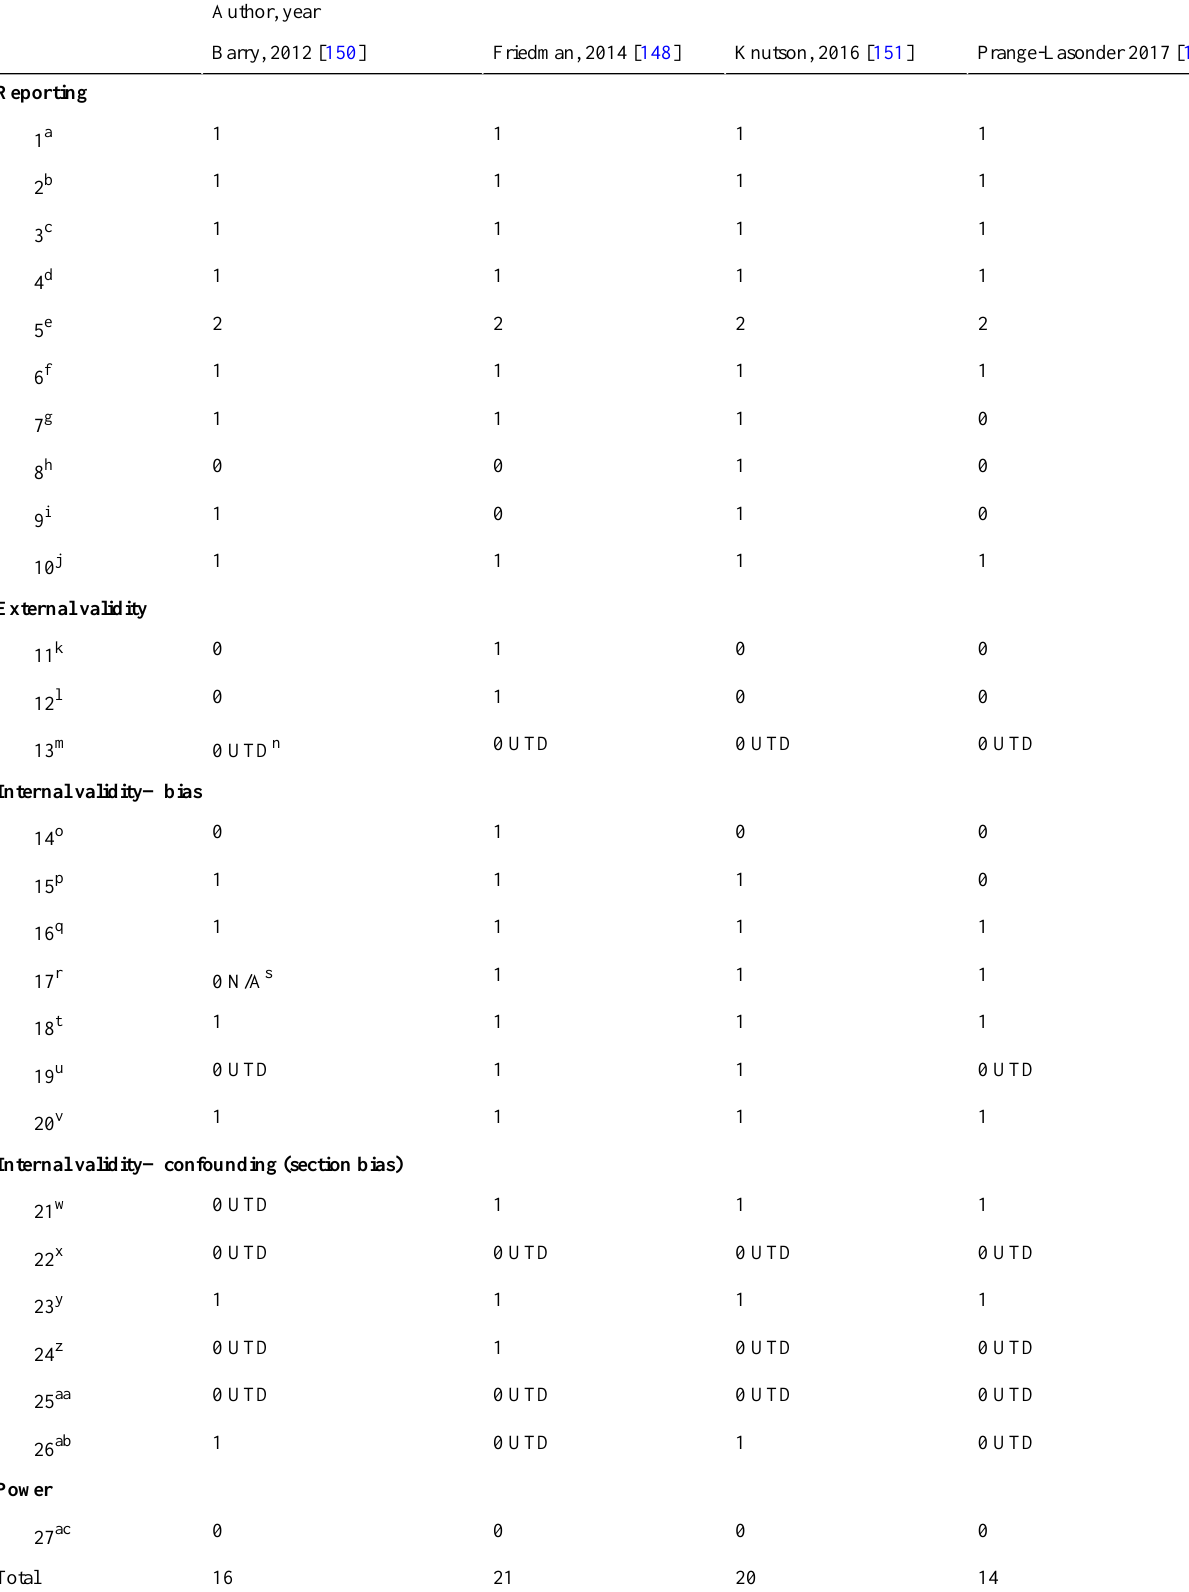
Table 2. Downs and Black quality assessment summary. Author, year